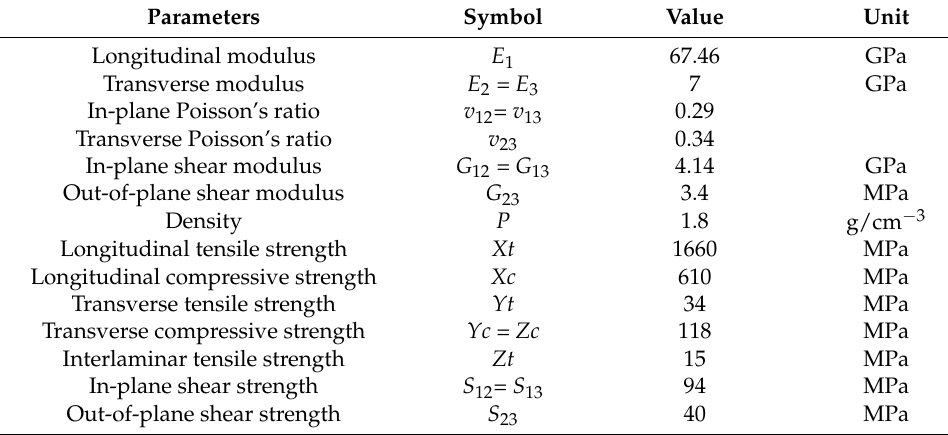
Table 4. Mechanical properties of S6/epoxy